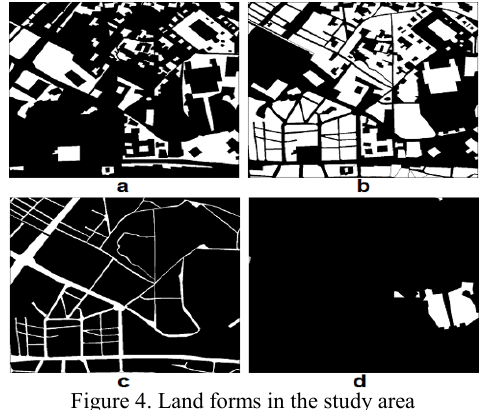
Figure 4. Land forms in the study area (a= open, 28.10%; b= building, 53.09%; c= road, 14.52%; d= forest,